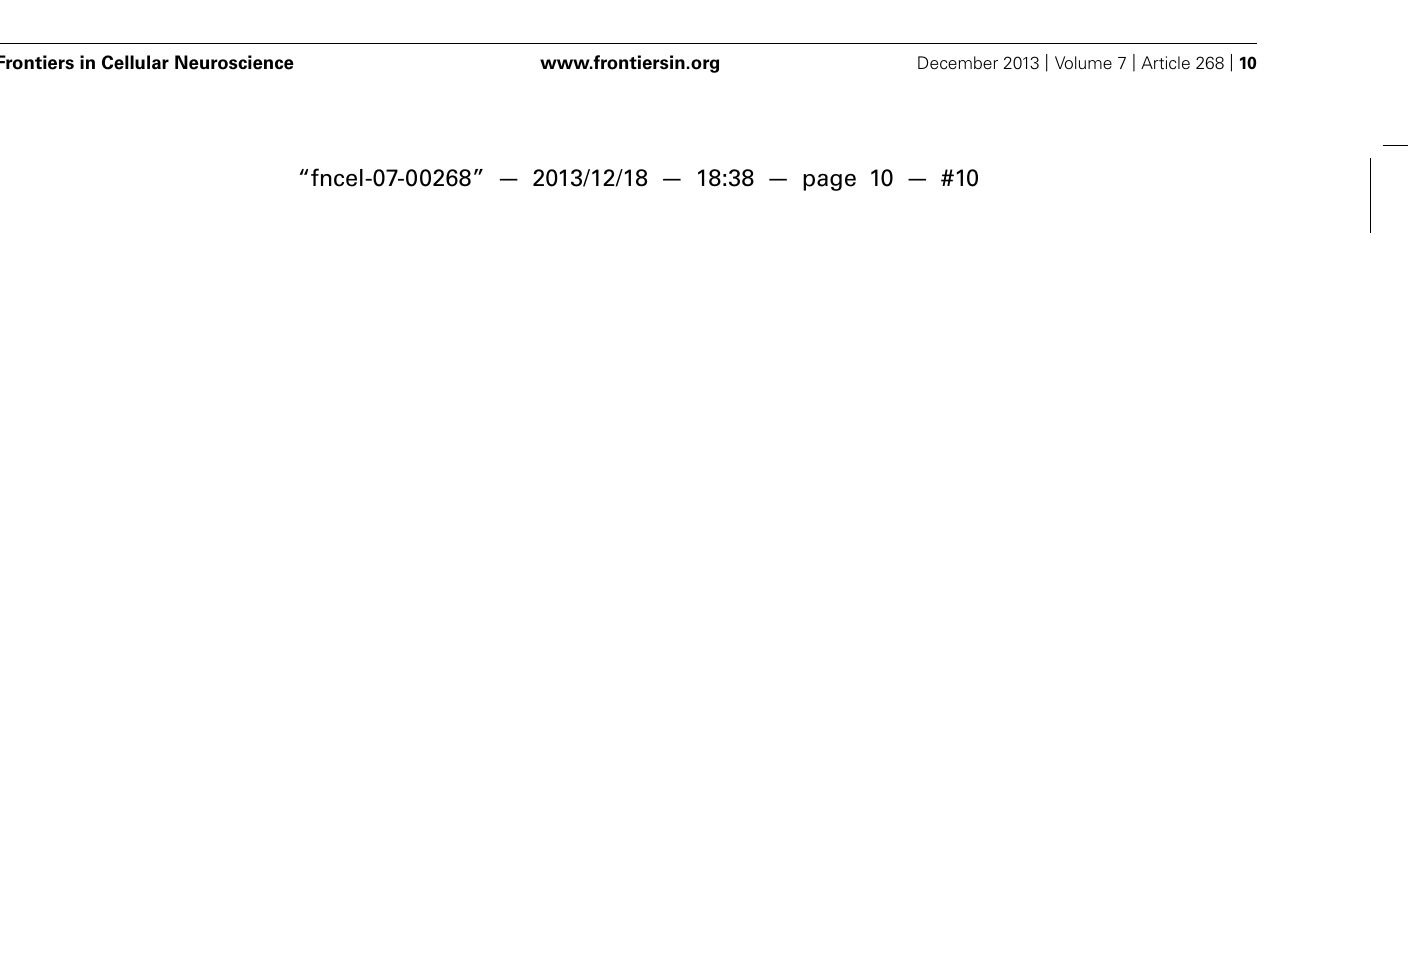
FIGURE 3 | Schematic representation of glia-glia interactions during development and pathology. Myelination is the result of a well orchestrated variety of processes affecting OPC biology (several of them are summarized on the blue shadow). During development, astrocytes and microglia release several molecules (in green) which controls diverse aspects